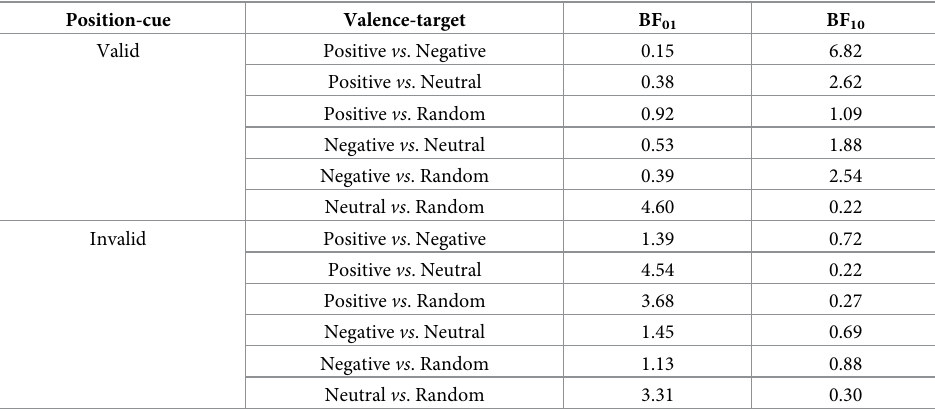
Table 2. Results of Bayesian paired sample t -test for valid